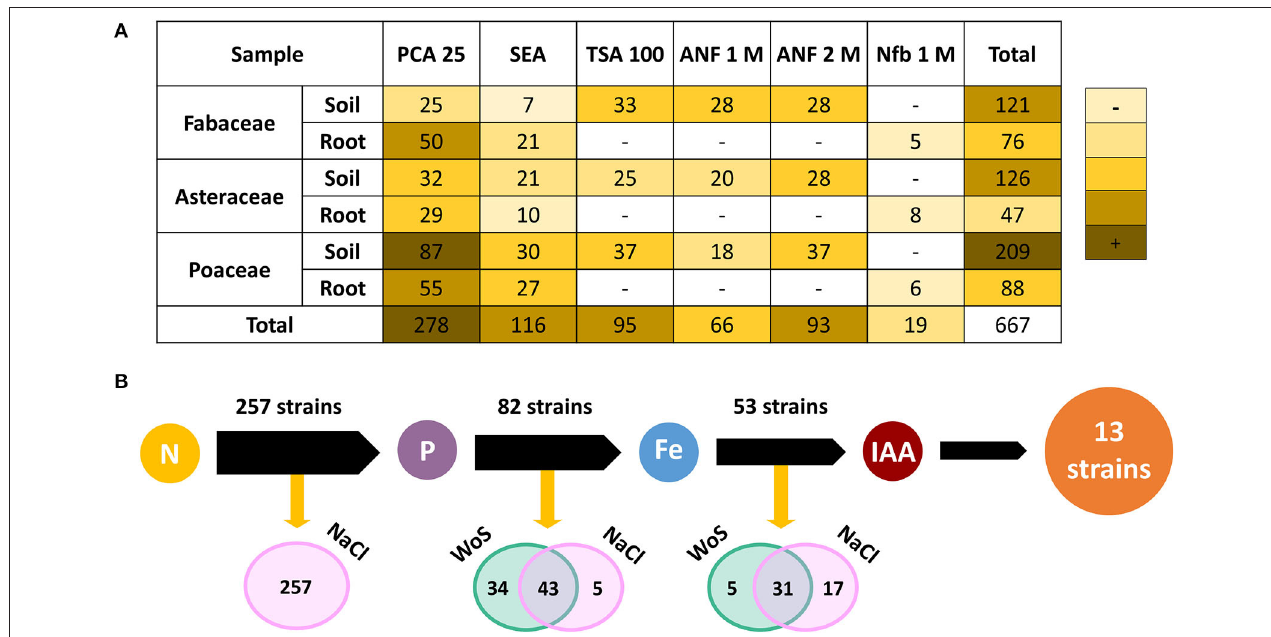
FIGURE 2 | Microbial isolation from samples collected from two sampling sites in the Salar del Hombre Muerto, Catamarca (Argentina). (A) A heat map of the number of bacterial isolates from samples that correspond to the surrounding bulk soil and rhizosphere of three plants from different genera: Fabaceae, Asteraceae, and Poaceae. The microbial isolation varied according to the culture media used: plate count agar (PCA 25), soil extract agar (SEA), tryptic soy agar (TSA 100), Ashby nitrogen-free agar (ANF) (1 and 2M NaCl), and a semisolid NFb medium for nitrogen-fixing bacteria, with 1M NaCl. (B) Stepwise screening of plant growth-promoting (PGP) properties on the isolated bacteria: a nitrogen fixation (N), phosphates solubilization (P), iron chelation (Fe), and indole-3-acetic acid production (IAA) without salt (WoS) and with 1M of NaCl (NaCl). All isolated strains were first evaluated for a nitrogen fixation; only positive strains for each activity in any salinity condition were evaluated on the next PGP activity indicated by the black arrows.